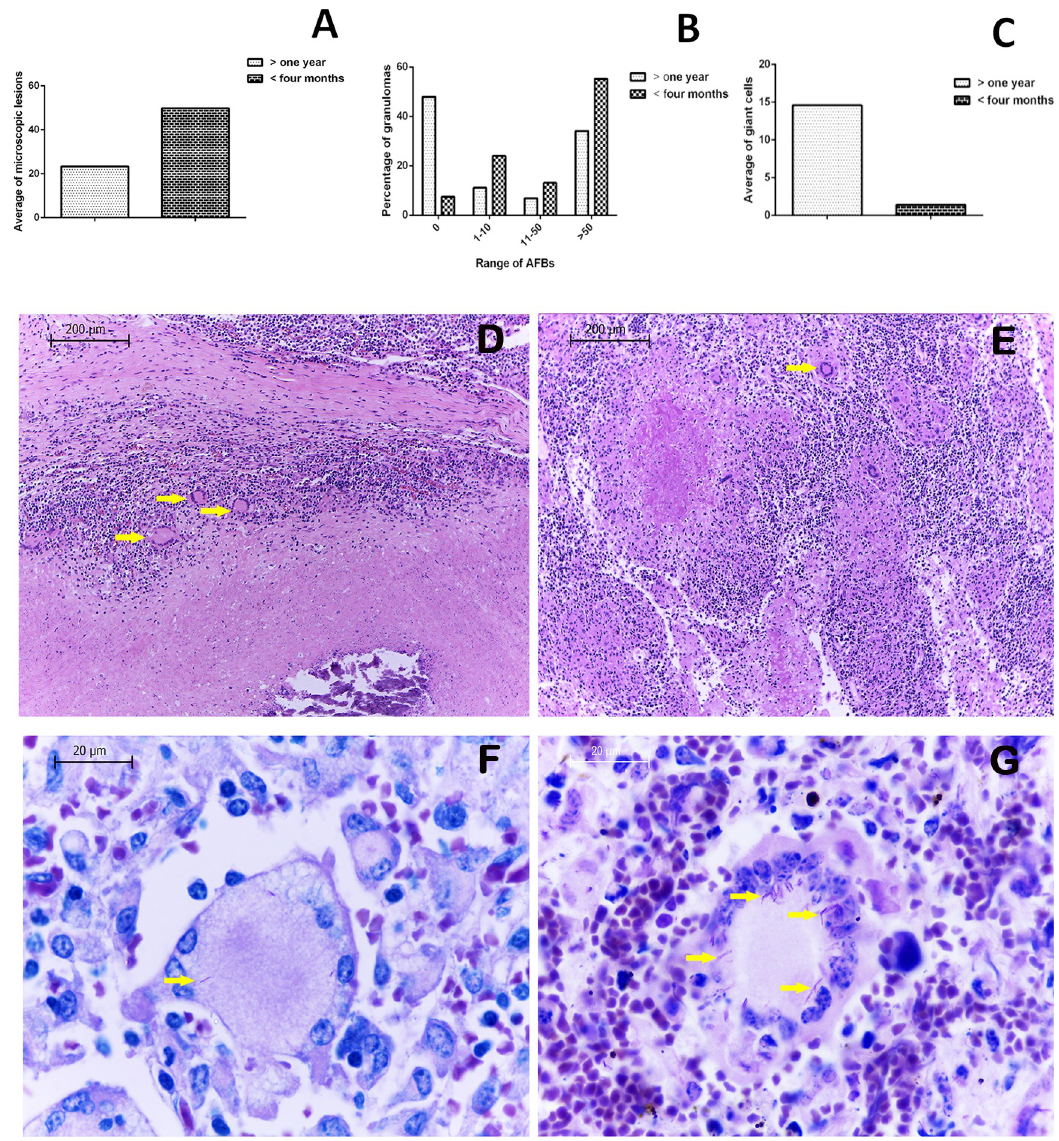
Fig 2. Calves had a greater number of granulomatous lesions and a higher bacilli scale when compared to adults. (A) Average microscopic lesions in cattle from both groups. (B) Granulomas with more than 50 bacilli are frequently seen in calves. (C) A lower average of giant cells is observed in calf lesions. (D) H&E, 40x, showing abundant giant cells (arrows) located between necrosis and fibrous capsule of a stage IV granuloma in adult cattle. (E) H&E, 400x, showing giant cells (arrows) close to an area with calcium deposits within a calf granuloma. Zielh Neelsen Stain (ZN) (F and G 1000x) (F) ZN stain showing a giant cell with intracytoplasmic bacilli in an adult bovine granuloma, and (G) ZN stain from a calf granulomatous lesion, showing a giant cell with abundant bacilli marked with